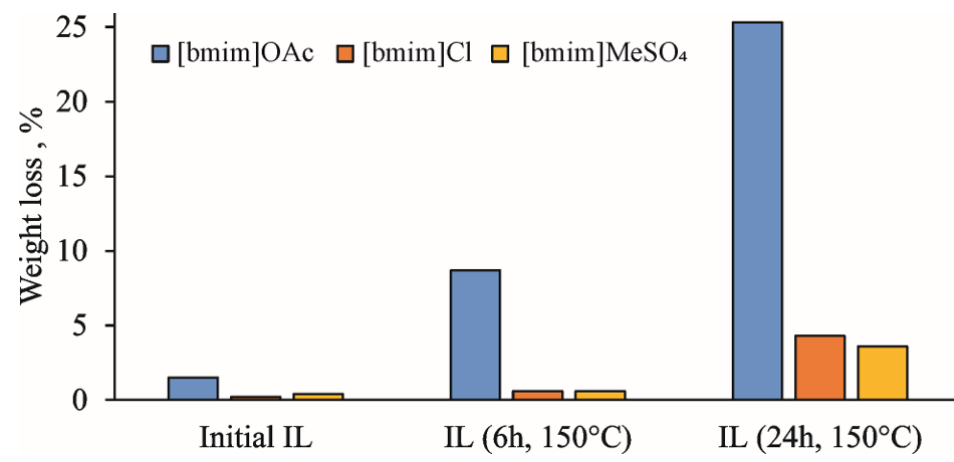
Figure 1. Weight loss of IL samples during vacuum drying at 60 °C.